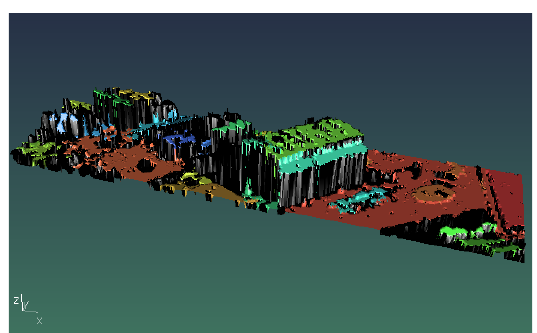
Figure 10: Extraction of planes from tomographic height